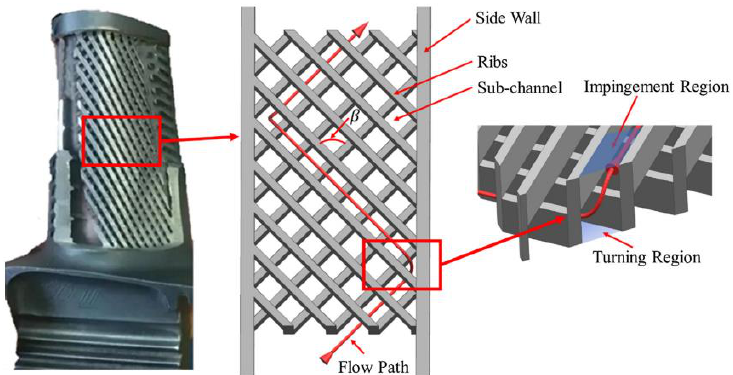
Figure 4. Schematic view of the lattice structure: A typical porous blade and flow network. Reprinted/adapted with permission from Ref. [73] . 2019, Elsevier Ltd.